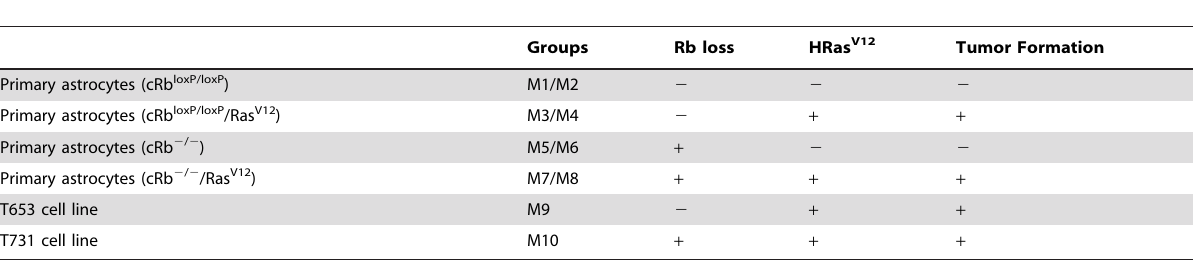
Table 1. Characterization of cell lines and primary